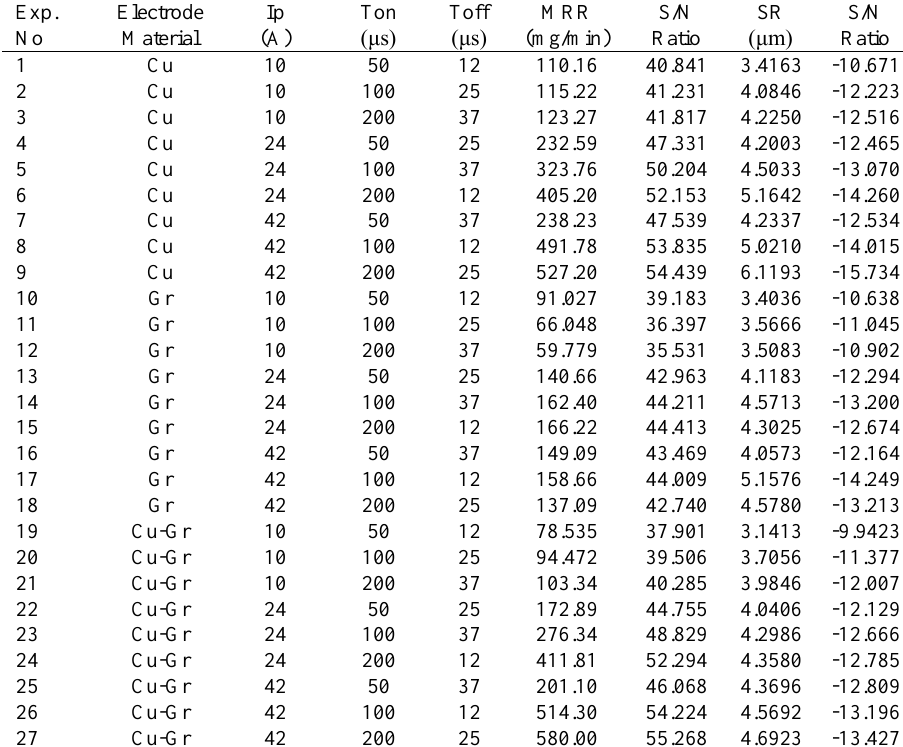
Table 3. Values for MRR and SR and their S/N